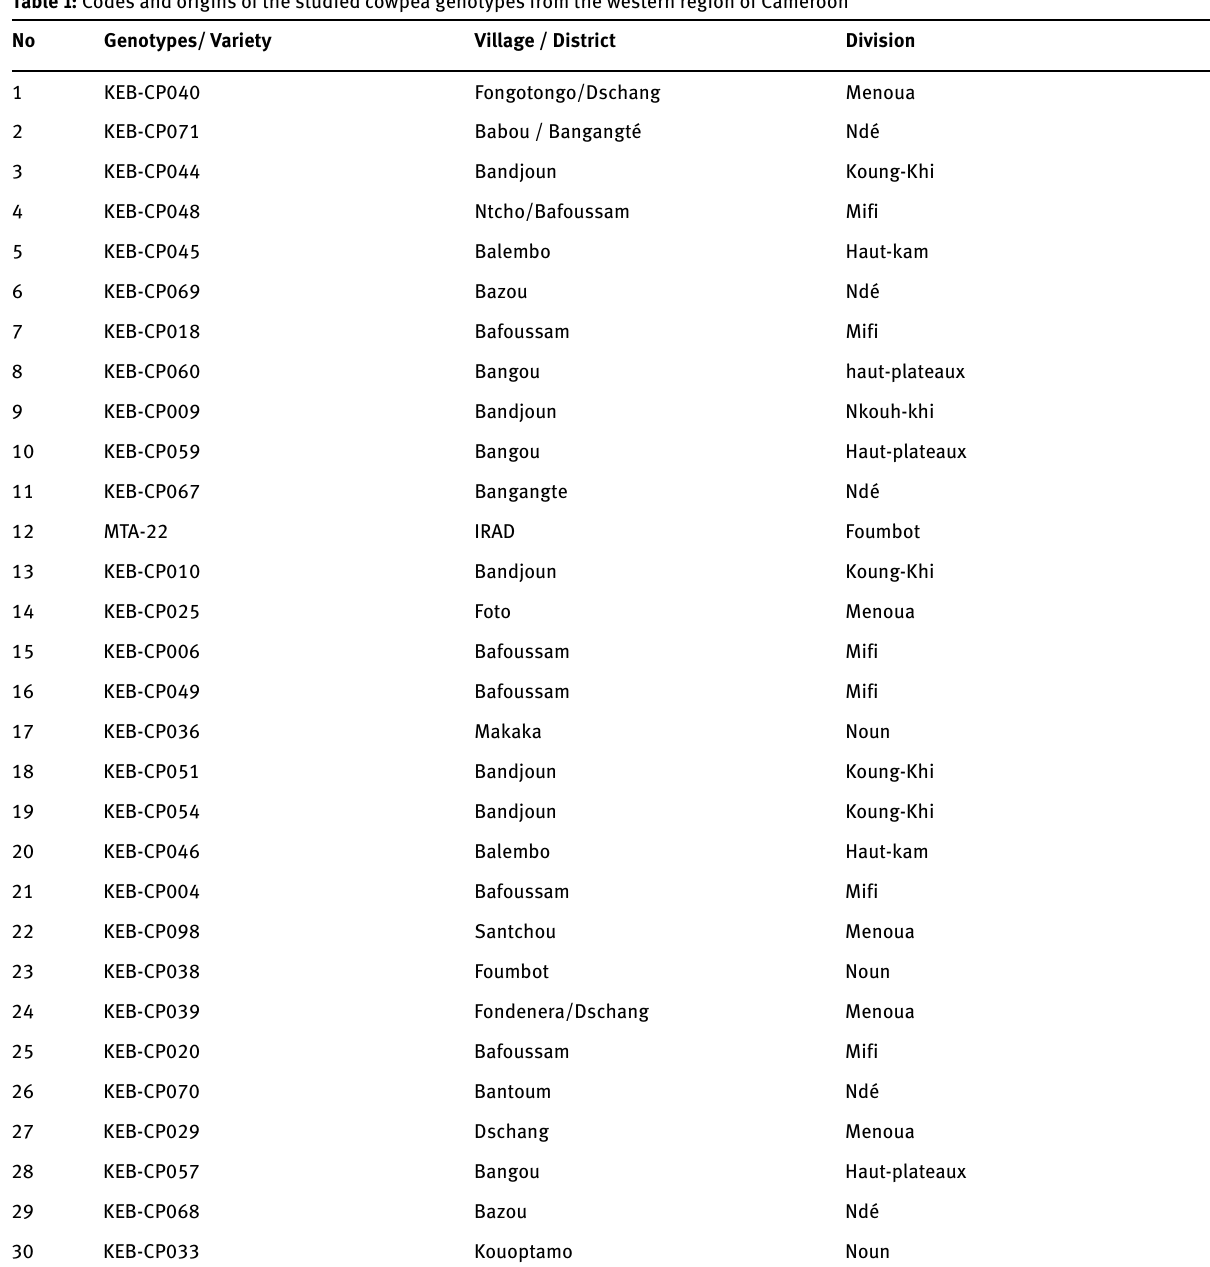
Table 1: Codes and origins of the studied cowpea genotypes from the western region of Cameroon No Genotypes/